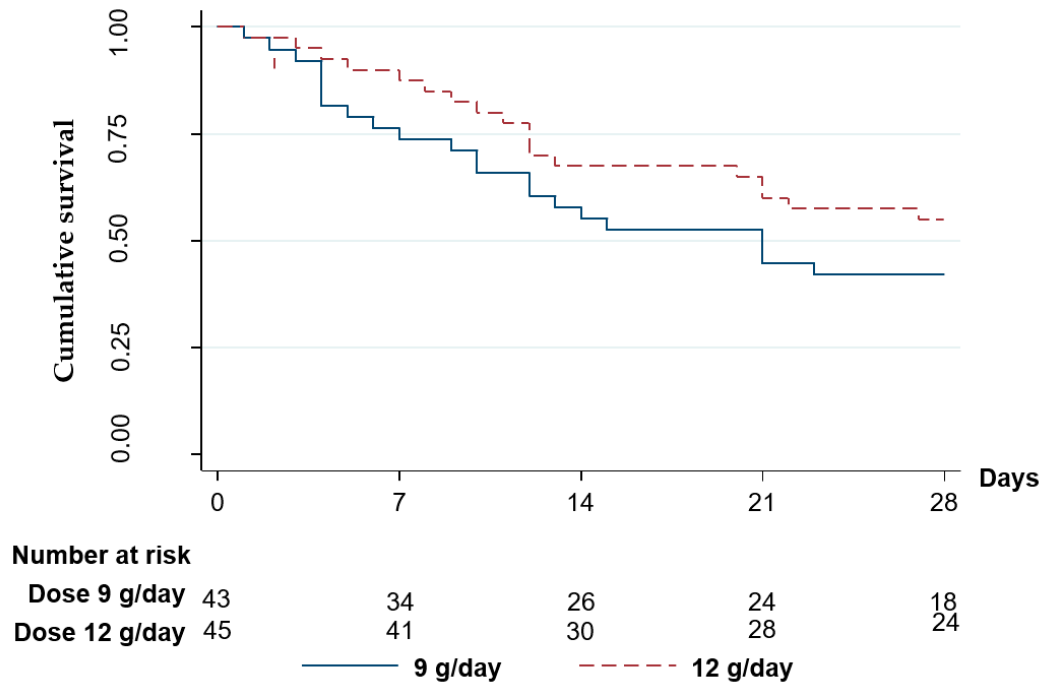
Figure 3. Kaplan–Meier survival curves for 28-day mortality of XDRAB pneumonia patients in relation to the administered dose of sulbactam . Table 2. Seven, 14, 28 days survival of XDRAB pneumonia patients in relation to the administered dose of sulbactam .